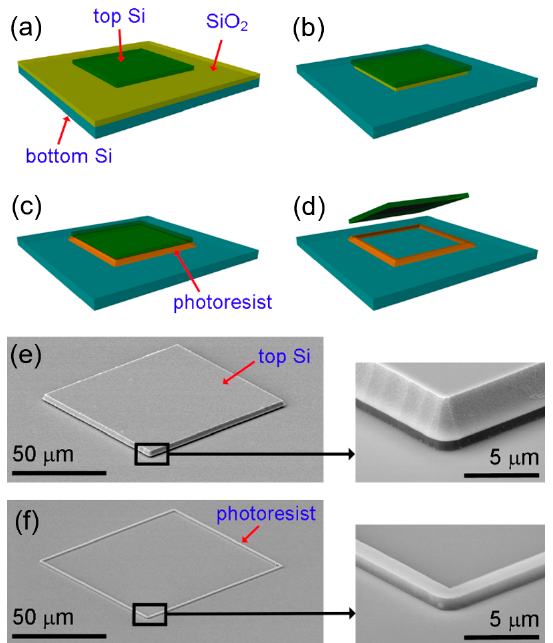
Figure 6. Overview of the process flow to fabricate Si inks which are ready to be retrieved using a stamp from a donor substrate. ( a ) A top Si layer is patterned on a silicon-on-insulator (SOI) wafer. ( b ) A sacrificial layer (SiO 2 ) is undercut etched. ( c ) A photoresist is spin-coated on the sample and flood-exposed to UV light. After development, a photoresist under the top Si remains. ( d ) The sacrificial layer is etched away, and the top Si is suspended on the photoresist and ready to be retrieved. Scanning electron microscope (SEM) images of a fabricated Si ink ( e ) and a residual photoresist after the Si ink retrieval ( f ). Reproduced with permission from [34].